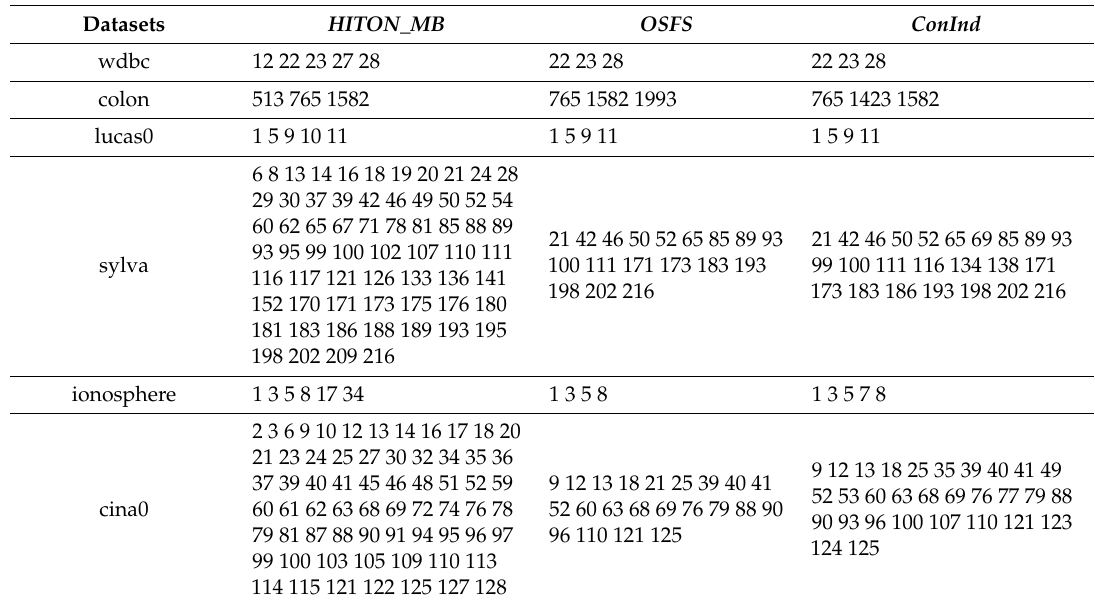
Table A1. Selected features in HITTON_MB , OSFS and ConInd